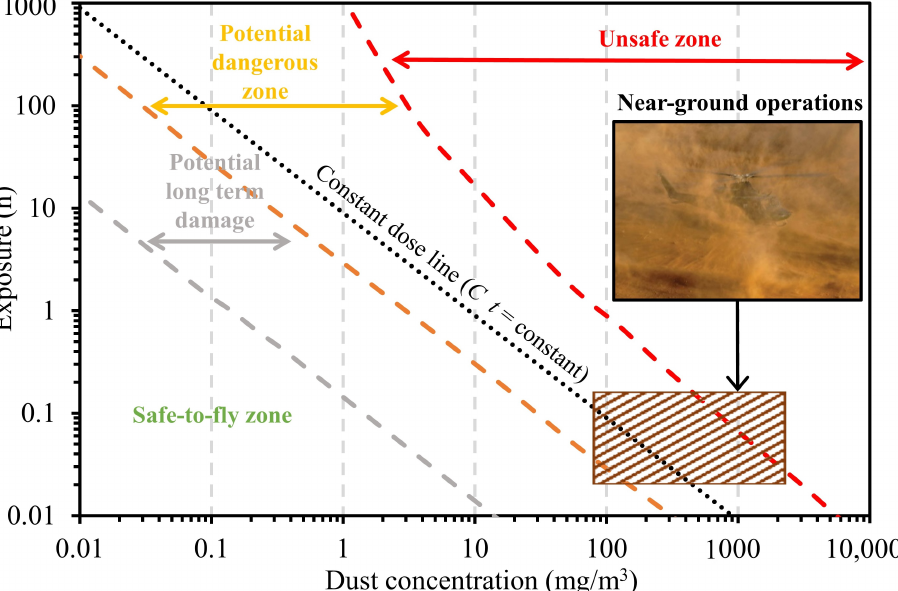
Figure 2. Safe-to-fly chart reporting the regions of safe operation, potential long-term damage operation, dangerous operation, and unsafe operation (adapted from [10]). The dashed rectangle reports the typical ground and near-ground conditions encountered by a rotorcraft in dusty